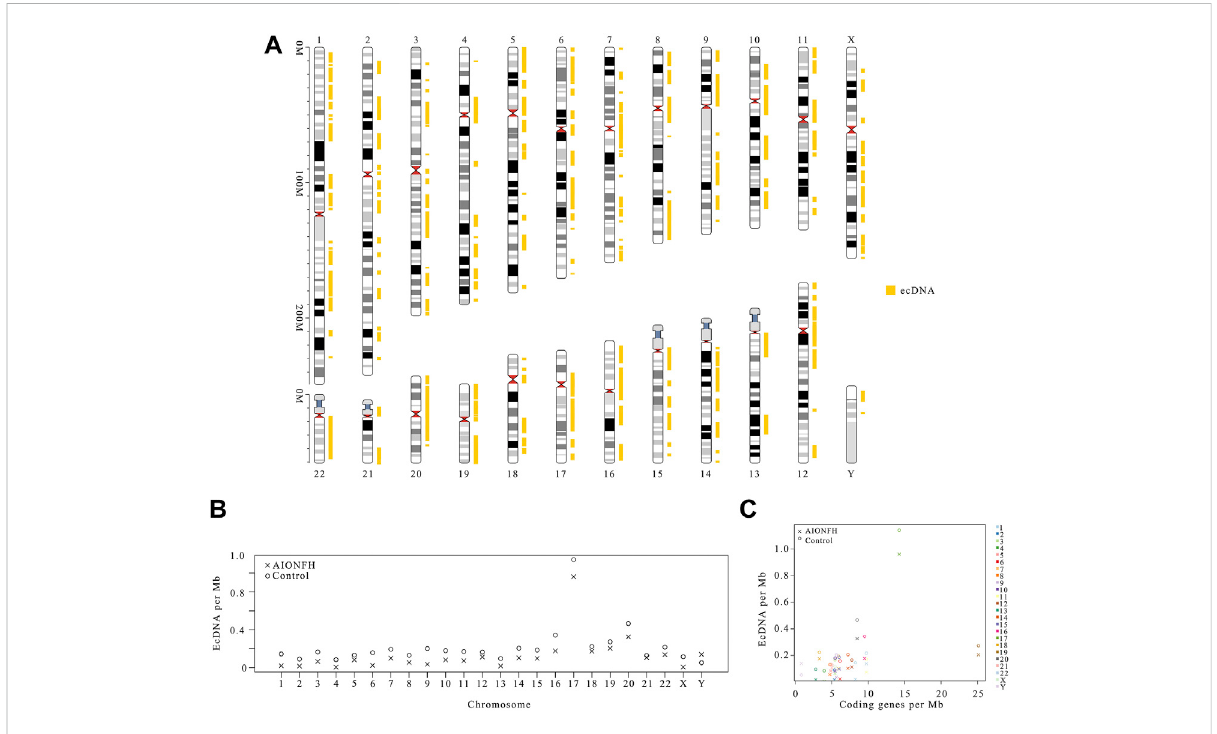
FIGURE 4 Genomic distribution of ecDNAs and the correlation with frequency of ecDNAs. (A) . The distribution of ecDNA fragment in chromosomes. EcDNA per Mb of AIONFH group and control group: chromosomes (B) and coding genes per Mb (C)